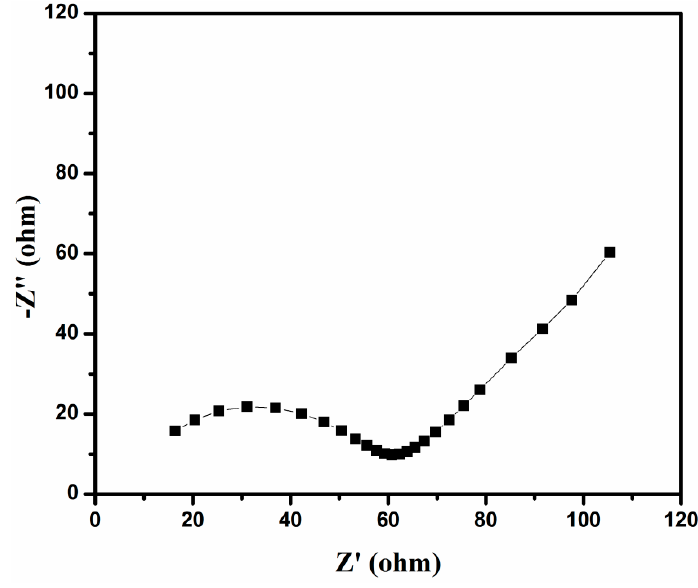
Figure 11. Plot for S/ PTSp/ PAni Composite material.